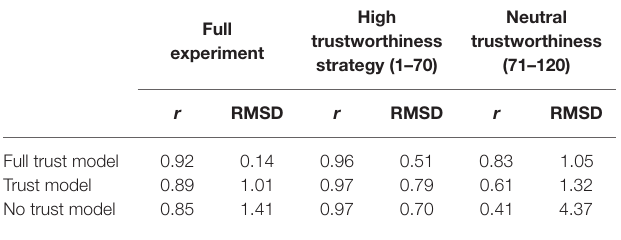
TABLE 1 | The correlation ( r ) and root-mean-squared deviation (RMSD) of the three models fit to the full experiment, high trustworthiness strategy (rounds 1–70), and neutral trustworthiness strategy (rounds 71–120).